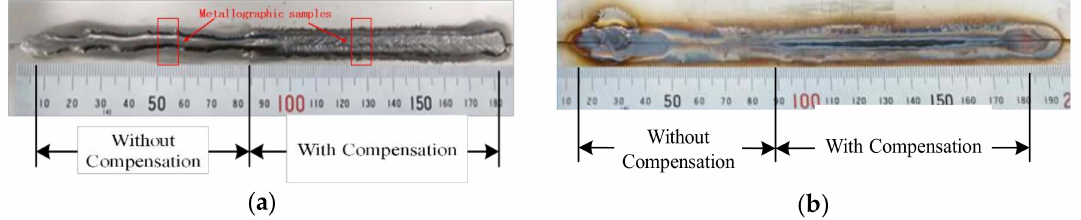
Figure 6. Weld bead shape of sample 2#: ( a ) Front view; ( b ) back